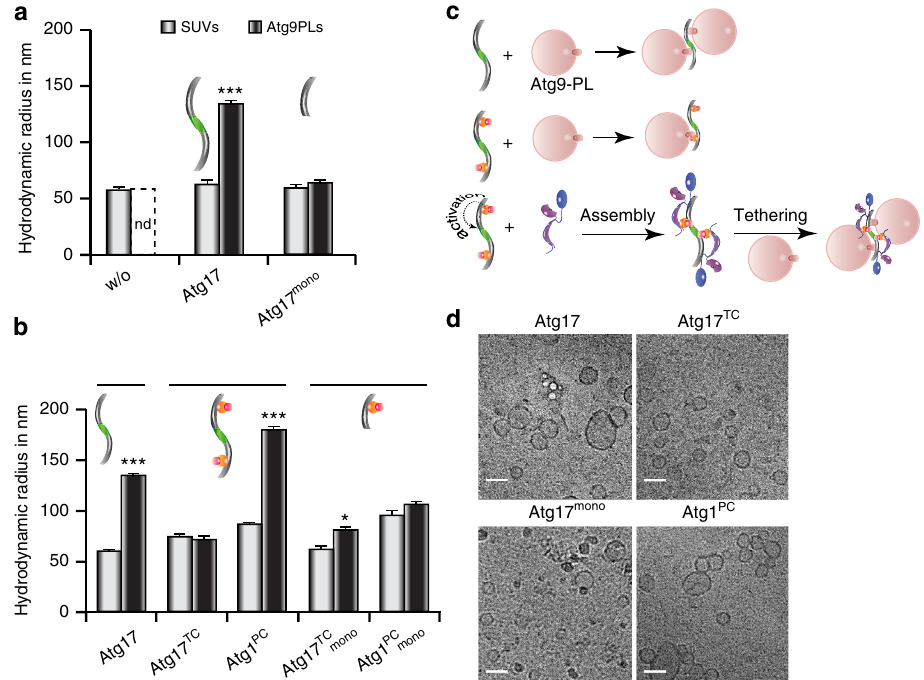
Figure 6 | Atg1 PC tethers Atg9–PLs. ( a ) The hydrodynamic radius of SUVs (white bar) and Atg9–PLs (black bar) obtained from DLS-experiments in the absence or presence of Atg17 and corresponding variants as illustrated by cartoons are shown. ND, not determinable (polydisperse). ( b ) Similar experiments shown in a were performed for Atg17 and Atg17-variants and that of corresponding Atg17 TC and Atg1 PC (sub)complexes. ( a , b ). Mean values ± s.d. of N ¼ 5 experiments are shown for both a and b . P values were calculated using two-tailed Student’s T -test (* P o 0.05; ** P o 0.01; *** P o 0.001). ( c ) The schematic drawing illustrates the experimental setup and summarizes the results obtained from DLS-experiments in a and b . ( d ) Cyro-electron micrographs of Atg9–PLs from samples used for DLS-experiments containing Atg17, Atg17 TC , Atg17 mono , and Atg1 PC . Atg17 tethers two and Atg1 PC tethers multiple vesicles together. Scale bar,